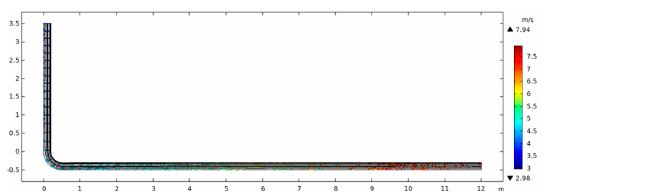
Figure 3. Meshing pattern.